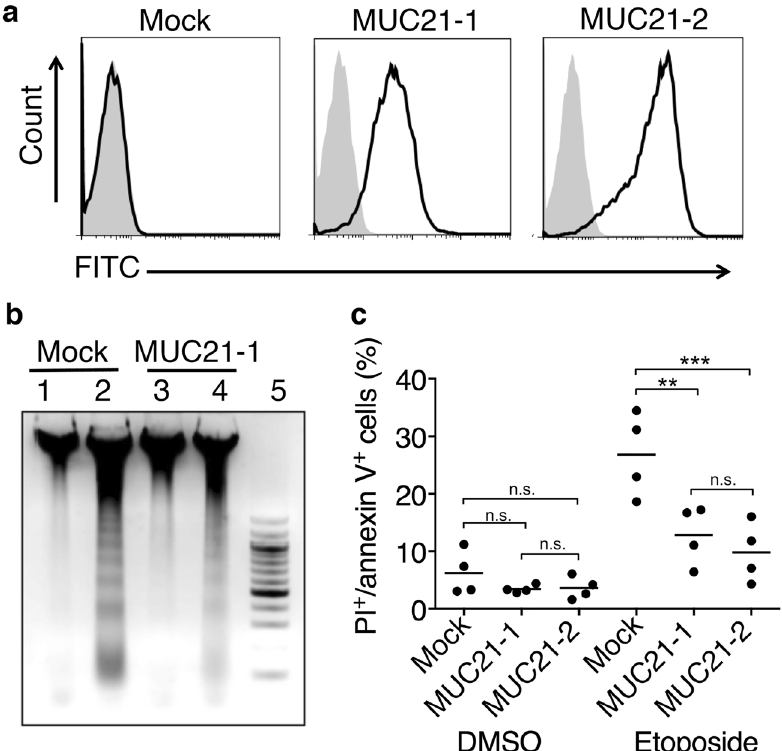
Fig. 1 MUC21 expression renders cells resistant to apoptosis. a Flow cytometric pro fi les of two clonal populations (MUC21-1 and MUC21-2) and mock transfectant of HEK293 cells transfected with full-length human MUC21. The cells were stained with anti-MUC21 monoclonal antibody heM21C followed by FITC-labeled goat anti-mouse IgG (solid line) and by control mouse IgG (shaded area). b Results of agarose gel electrophoresis of DNA extracted from HEK293 cells untreated (lanes 1 and 3) or treated (lanes 2 and 4) with 100 µM etoposide for 24 h. The cell clones for Mock and MUC21 are the same with the clones shown in ( a ). Lane 5 shows the molecular weight marker ladder. ( c ) Percentage of apoptotic cells among mock-transfectant cells and two clones transfected with full-length MUC21 (MUC21-1 and MUC21-2) as determined by fl ow cytometric analysis 48 h after incubation with DMSO or 100 µM etoposide. Four independent experiments are shown. The mean is indicated as a horizontal line. Two-way ANOVA with Tukey ’ s multiple-comparison test. ** p < 0.01, *** p < 0.001, n.s. not signi fi